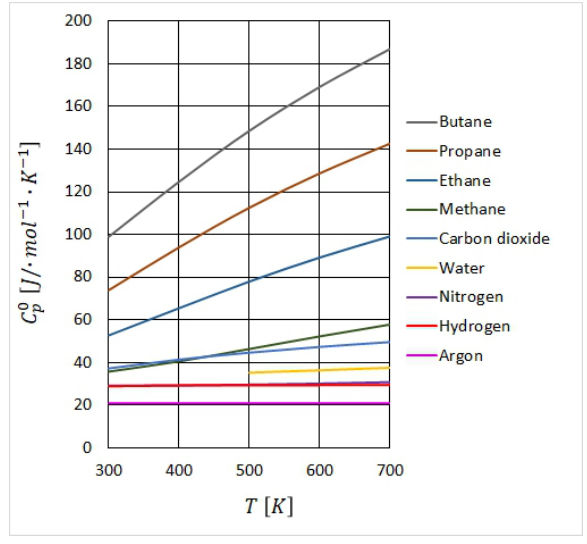
Figure 3. Dependence of C 0 several common used gases